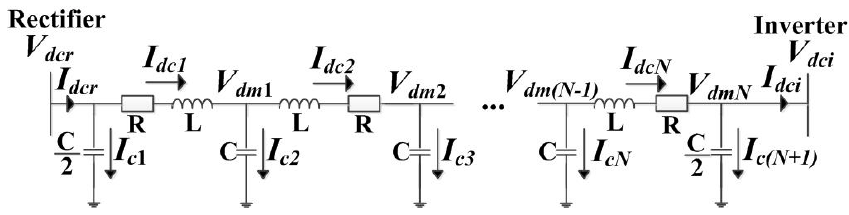
Figure 9. A schematic diagram of proposed DC line model using N π‐ sections.